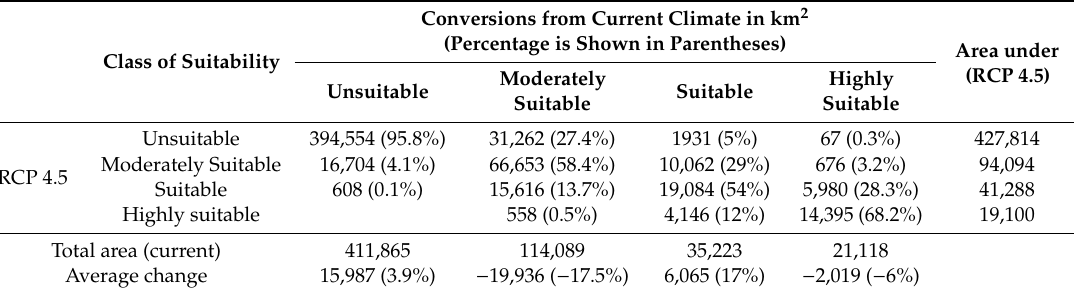
Table 3. Changes in land suitability for maize production under RCP 4.5 in Kenya for 2070 compared to current suitability.